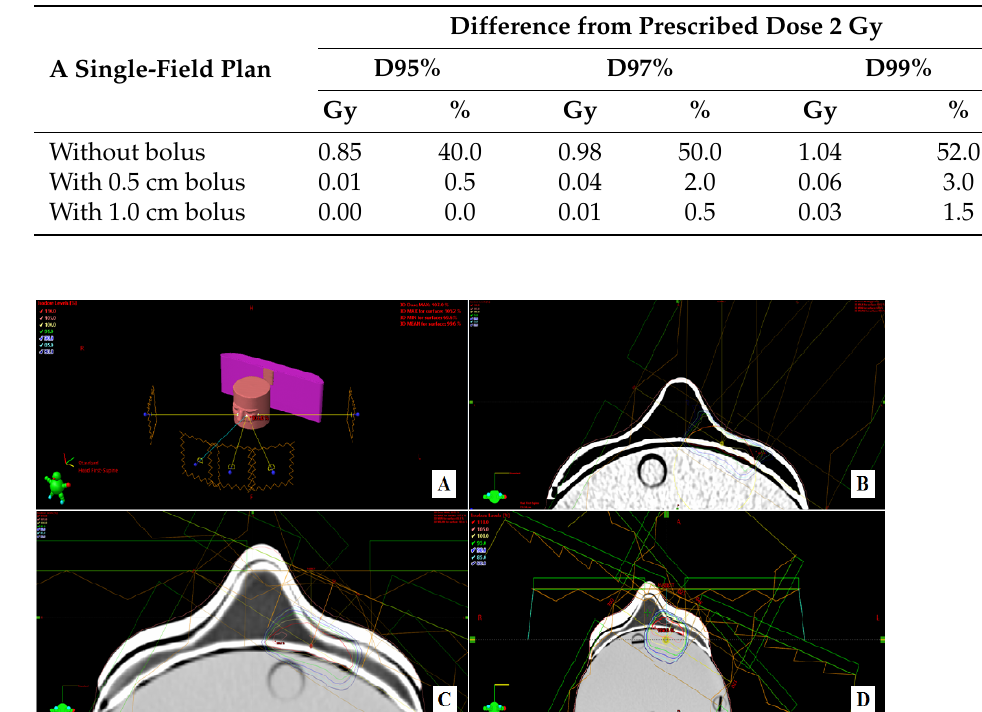
Figure 9. Isodose distributions in five-field intensity-modulated radiation therapy plans: ( A , B ) sagit- tal and frontal views of CT head phantom with attached patient-specific phantom; ( C ) patient-specific phantom with attached 0.5 cm thick bolus; ( D ) patient-specific phantom with attached 1.0 cm thick bolus.